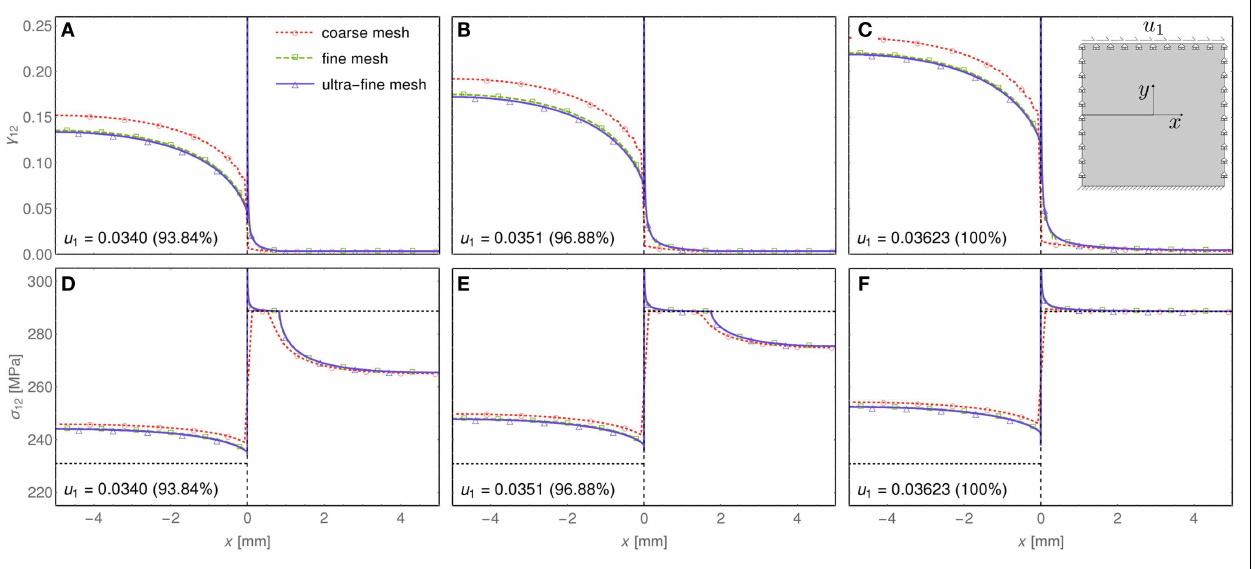
FIGURE 10 | Shear deformation γ 12 (A–C) and shear stress σ 12 (D–F) along the x -axis containing the pre-existing shear band for the case of a material close to a shear band instability E p = 300MPa .The black dotted line, in the bottom part of the figure, indicates the yield stress level, lower